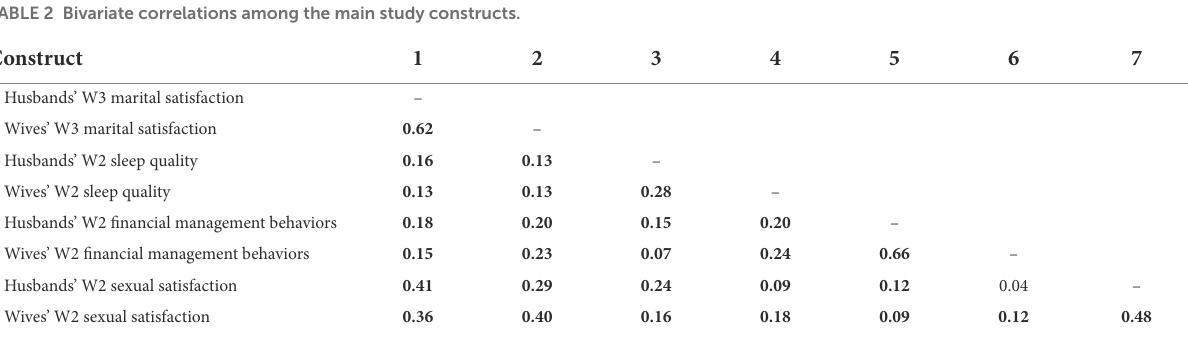
TABLE 2 Bivariate correlations among the main study constructs.